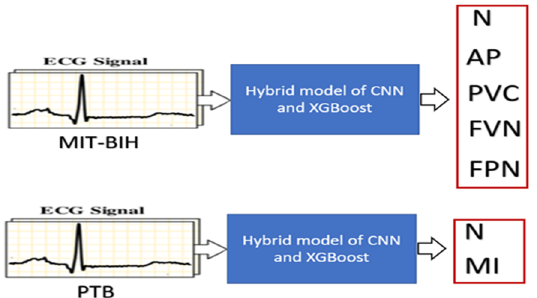
Figure 1. Illustration of the proposed method. The ECG signals fed into the suggested model are to be classified. The upper half of the figure shows the MIT-BIH dataset used for multiclass classification into five classes, while the lower half shows the PTB dataset for binary classification.